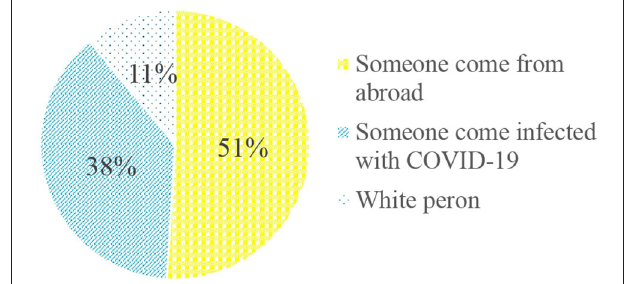
FIGURE 1 | Stigmatized group during the COVID-19 pandemic among the Dire Dawa Administration residents, Eastern Ethiopia, September 2020.